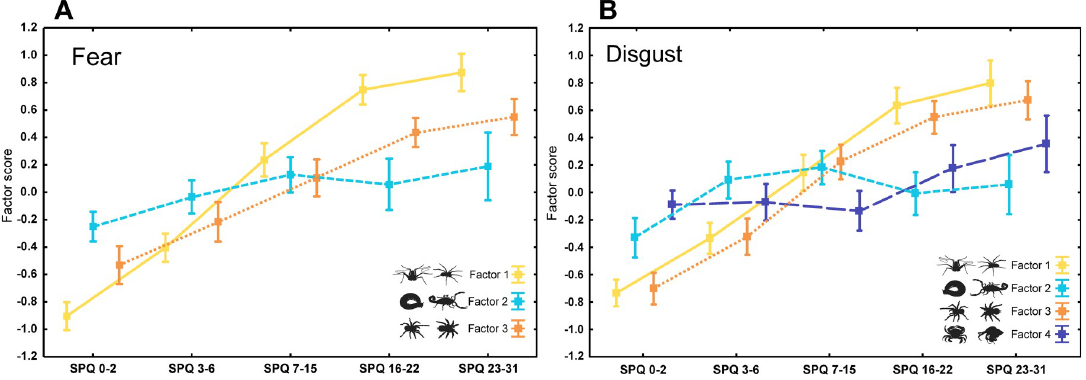
Fig 5. Means and standard error bars of factor scores as extracted from FA for each SPQ category of respondents. In both fear (A) and disgust (B), Factor 1 roughly corresponds to fear/disgust of gracile spiders and spider-like chelicerates, Factor 2 to fear/disgust of other arthropods, Factor 3 to fear/disgust of hairy robust spiders, and Factor 4 to disgust of